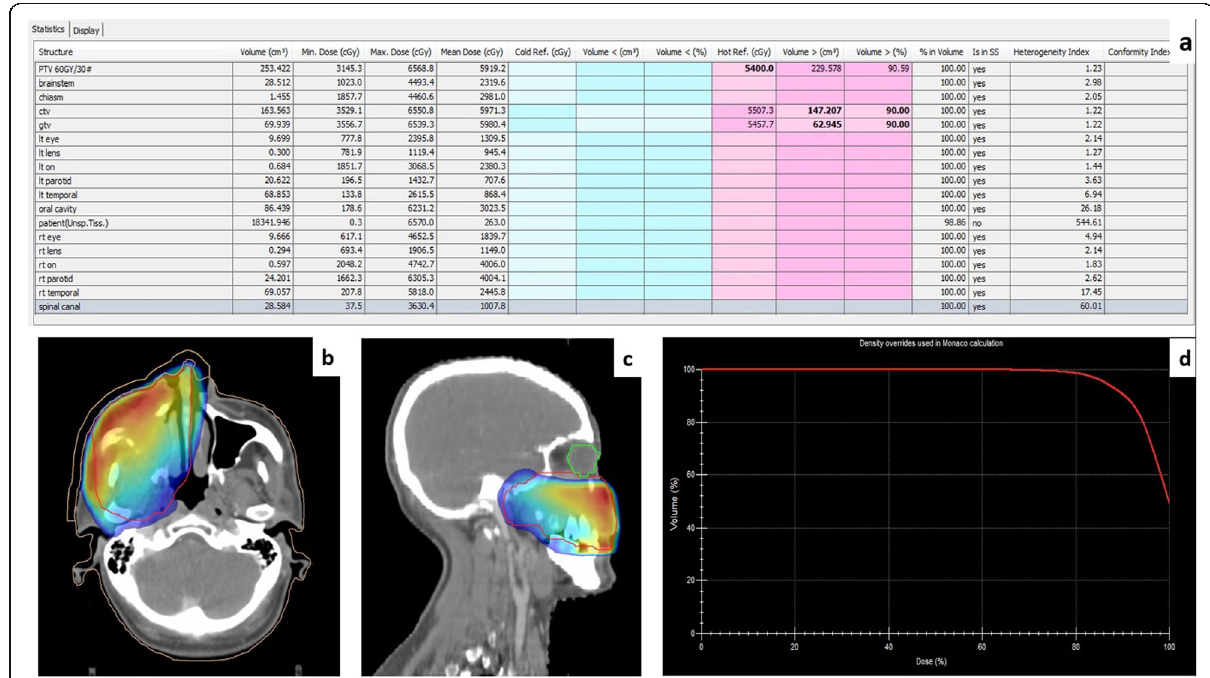
Fig. 3 a Table showing dose received by OAR. b and c IMRT plan showing dose color wash of 90% isodose coverage of PTV. d DVH of RT plan (red line =